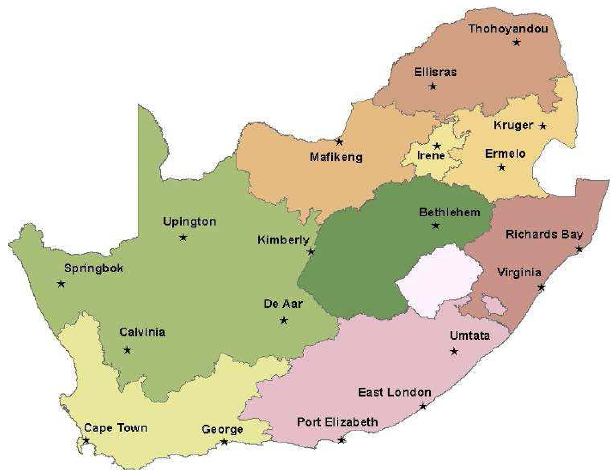
Fig. 3. 19 of 21 South African Weather Service LDN sensor sites operational during the time period December/January/February 2009/2010 (without the two newest sensors, at the time, at Spring- bok (Northern Cape) and Aliwal North (Eastern Cape); Gijben, 2012; image from Gill,